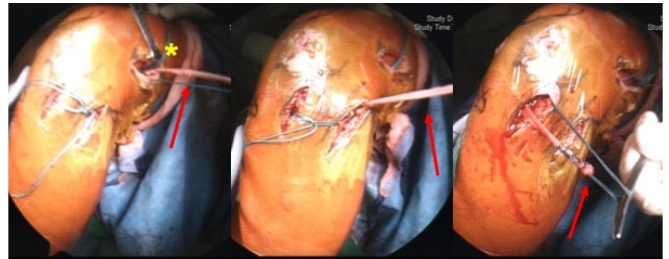
Figure 2. Image of combined ACL and ALL reconstruction. (Red arrow: gracilis was used as an autograft for ALL reconstruction. Asterisk: the anatomic femoral tunnel of the